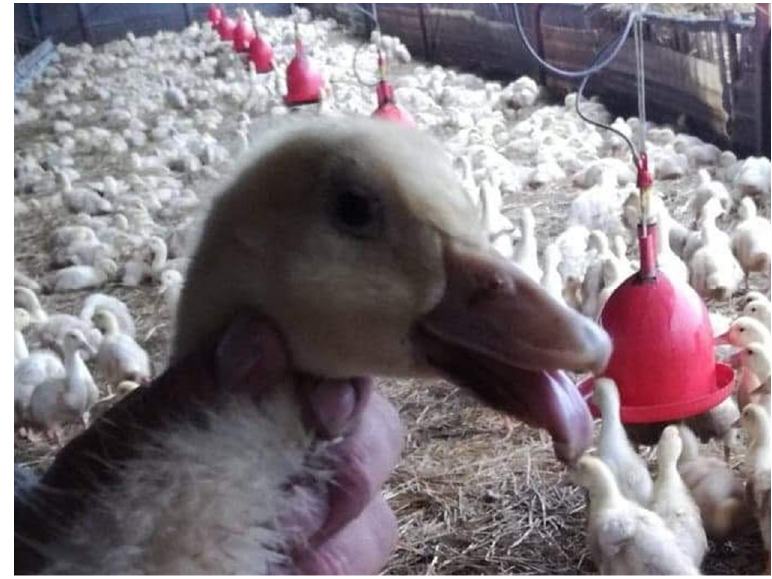
Figure 1. Picture of duck with SBDS signs: shortening of the beak and protruding and dropping tongue.